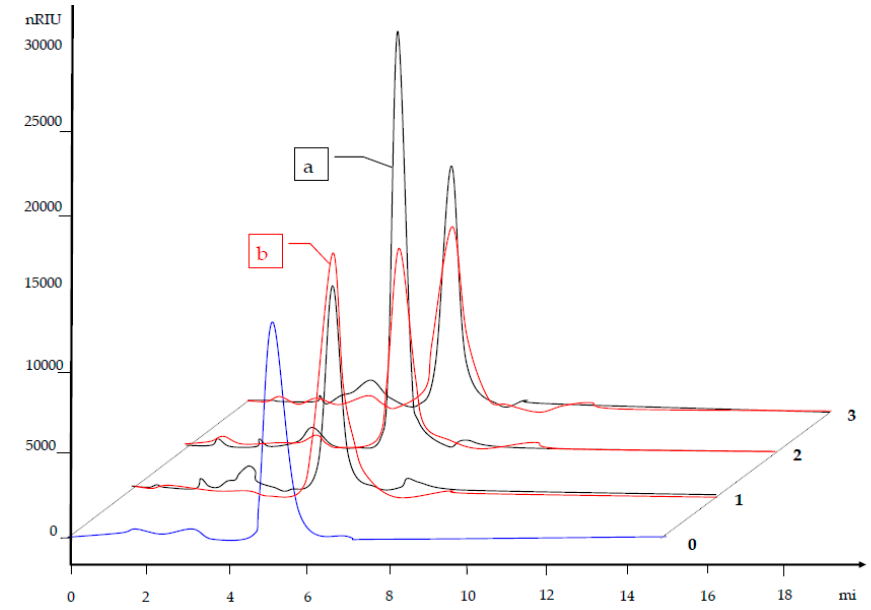
Figure 4. HPLC chromatograms; a—AA starch copolymer, b—HEMA starch copolymer; 0—hydrolysed starch, 1—grafted with AIBIN initiators, 2—grafted with BP initiators, 3—grafted with KPS initiators. Table 4. Individual parameters of chromatograms for copolymer samples.